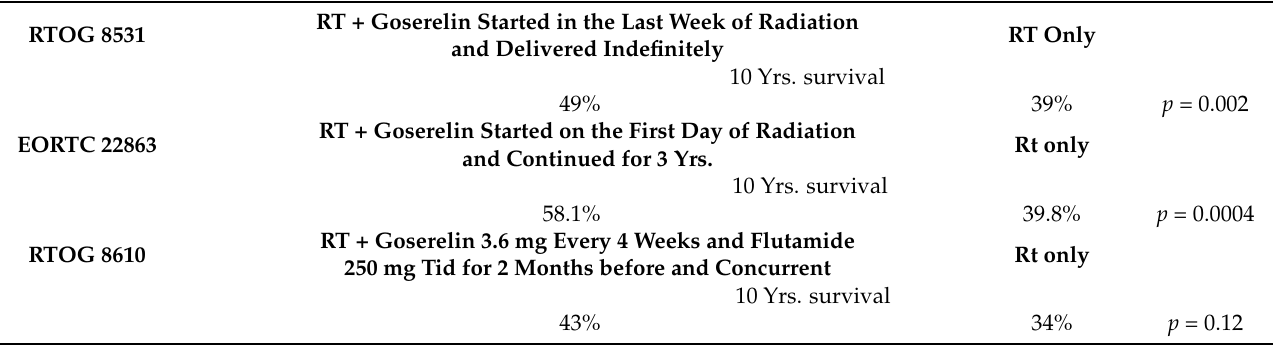
Table 1. Clinical trials comparing radiation therapy only to radiation therapy + hormonal therapy. RT + Goserelin Started in the Last Week of Radiation RTOG 8531 and Delivered